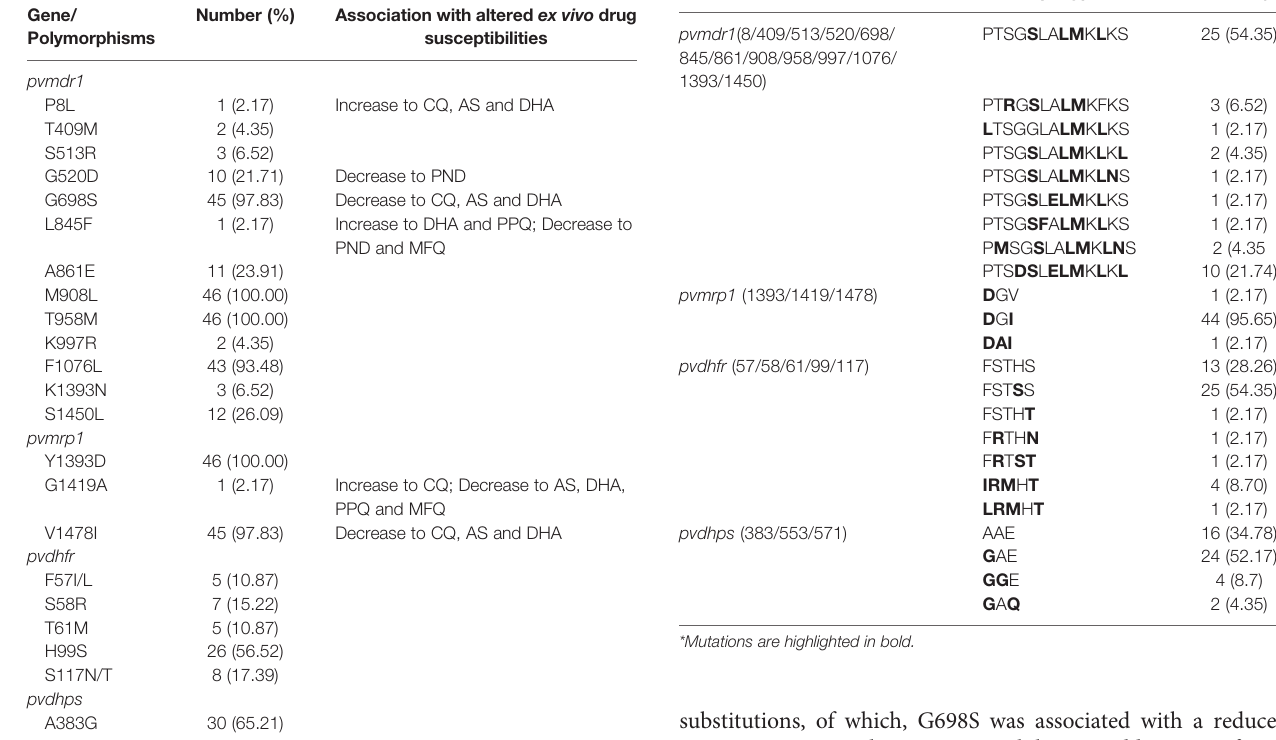
TABLE 3 | Prevalence of pvmdr1 , pvmrp1 , pvdhfr and pvdhps genes haplotypes*. Genes